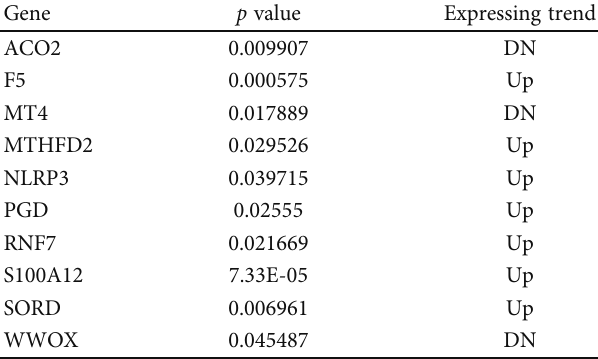
Table 1: Ten of 199 CRGs were di ff erentially expressed between CAD and normal samples, including 7 upregulated and 3 downregulated